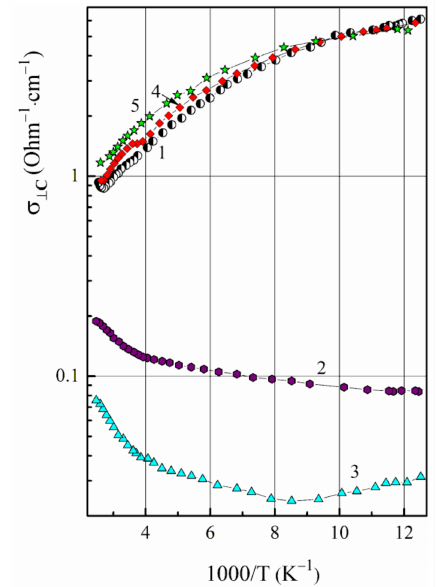
Figure 1. Temperature dependences of conductivity along the layers for the n -InSe samples: pristine (1), first-time and repeatedly intercalated with RbNO 3 (2 and 3, respectively), and annealed in vacuum (4 and 5,